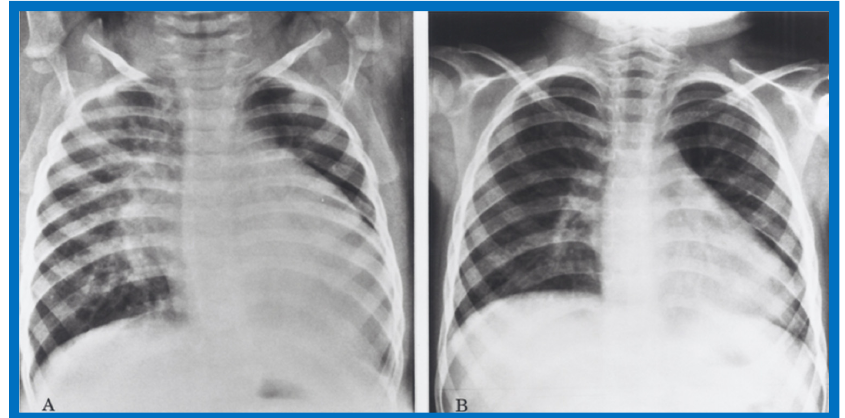
Figure 41. Selected M-mode recording from the parasternal short axis view of the left ventricle (LV) prior to ( A ) and following ( B ) hydrazine therapy from a different infant. Also, note the significant improvement in the LV size and function.